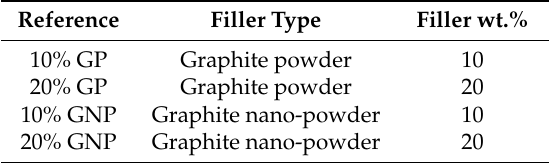
Table 9. Manufacturing runs and resume of the characteristics of graphite based samples.